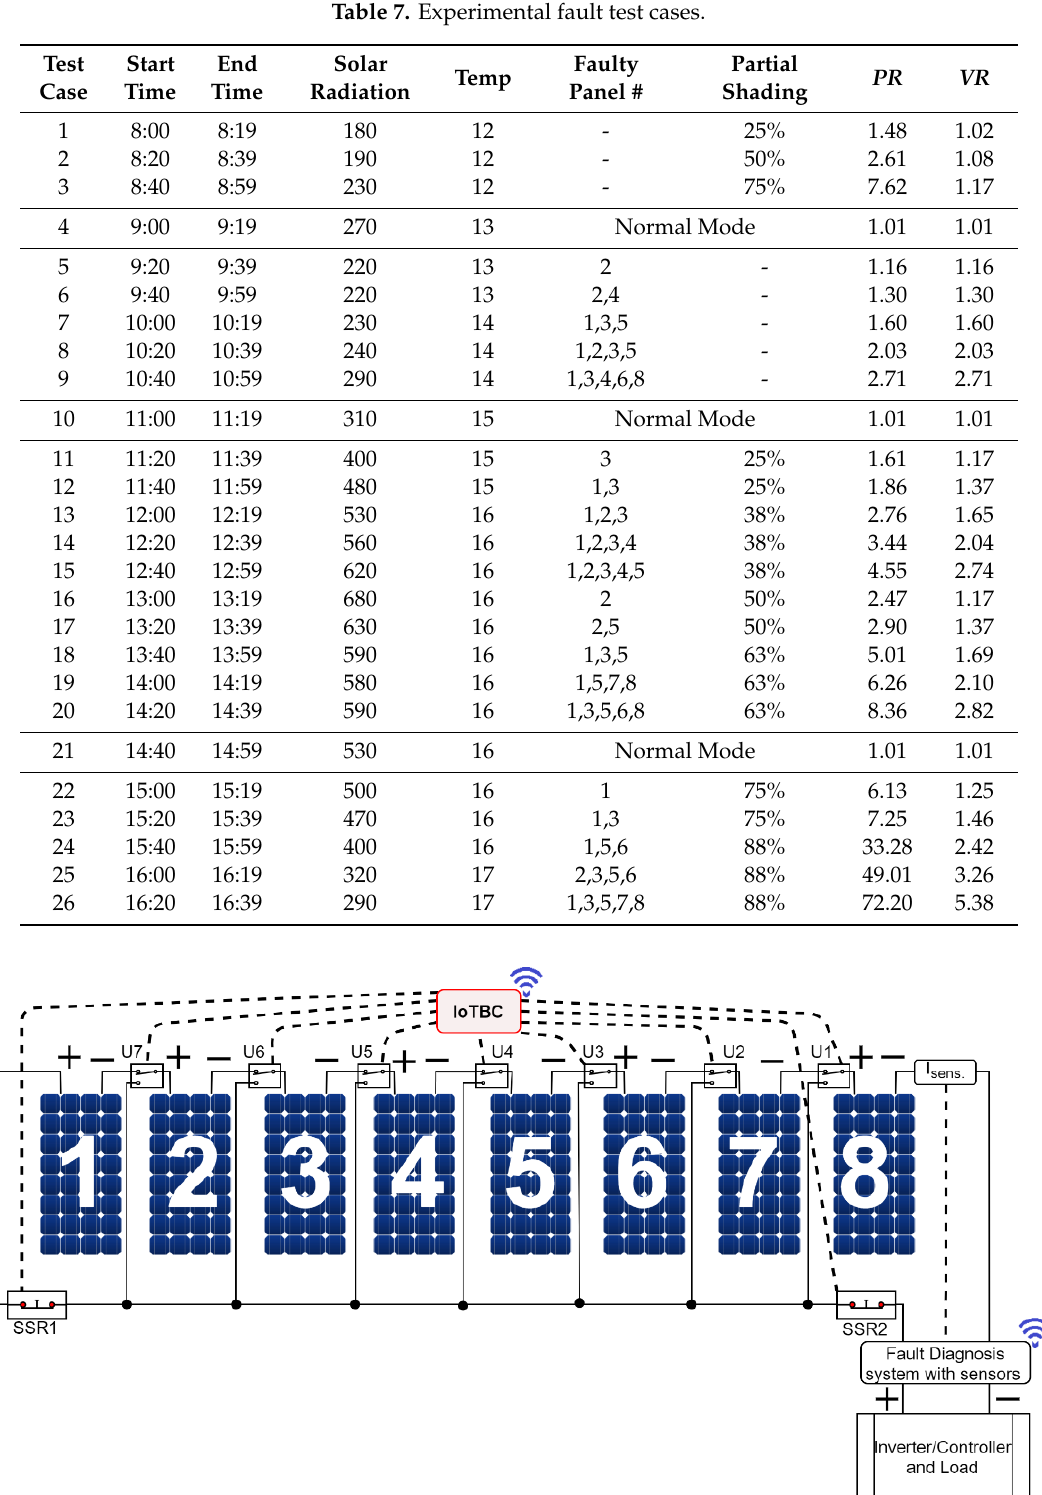
Table 7. Experimental fault test cases.